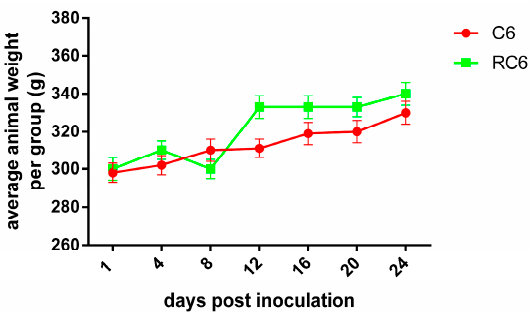
Figure 6. Average animal weight in C6 and RC6 group followed during 24 days after cells’ inoculation.